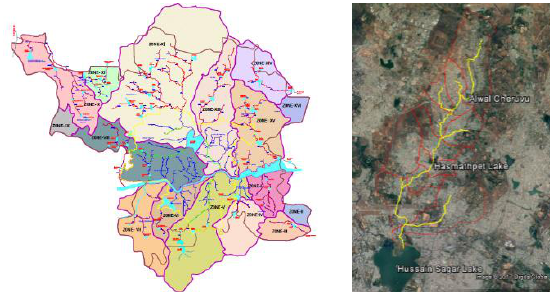
Figure 2: Stormwater zone map of Hyderabad city (left) and google map location of Zone III (right)